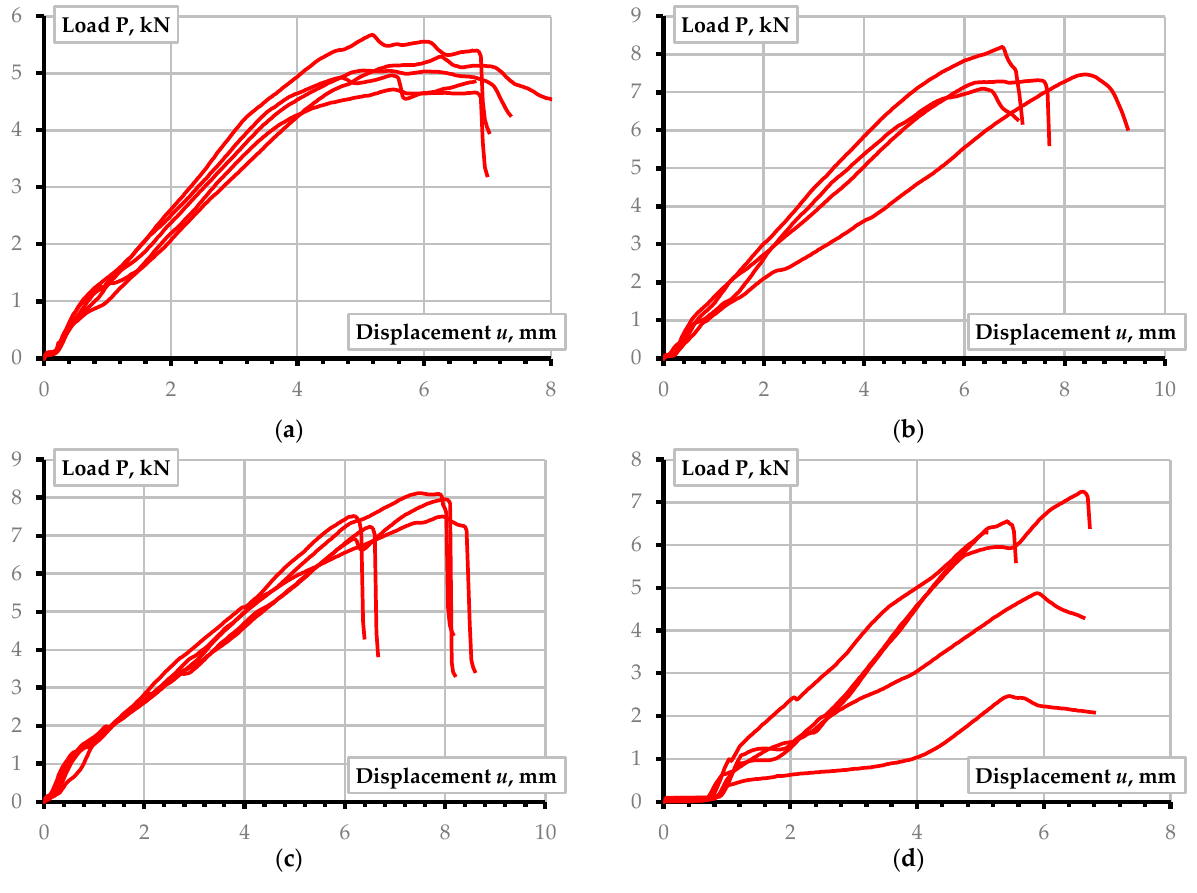
Figure 6. Characteristic load-displacement diagrams of the tested joints: ( a ) A-6 connection type; ( b ) A-8 type; ( c ) A-10 connections; ( d ) A-12 joints. Note: the diagrams of each graph show responses of five nominally identical specimens.